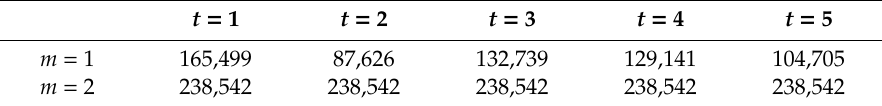
Table 19. Quantity produced by selected supplier / manufacturer in each period of time.